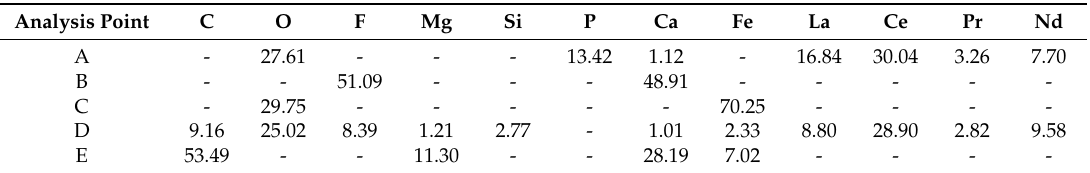
Table 4. Energy dispersive X-ray spectroscopy (EDS) results of the mineralogical phases in Bayan Obo tailings (wt. %).